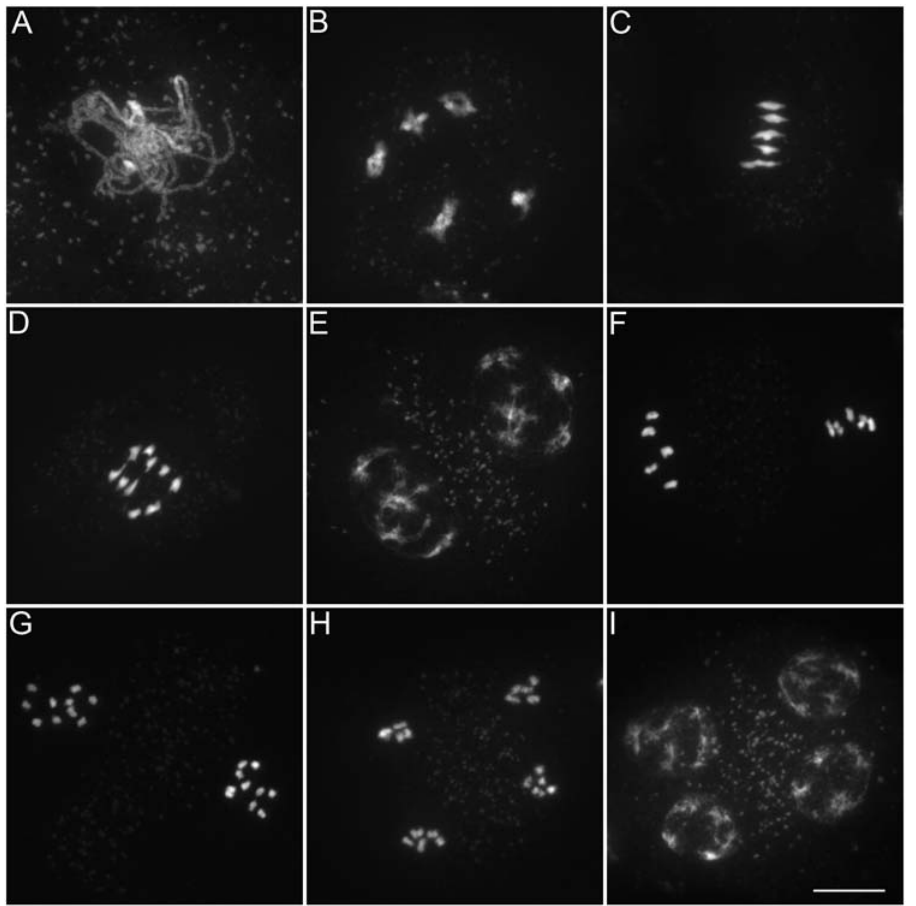
Figure 4. Meiosis in wild type. (A) Pachytene. Homologous chromosomes are fully synapsed. (B) Diakinesis. Five pairs of homologous chromosomes (bivalent), linked by chiasmata, are observed. (C) Metaphase I. The five bivalent are aligned on the metaphase plate. (D) Anaphase I. The homologous chromosomes are separated. (E) Telophase I. (F) Metaphase II. The pairs of sister chromatids align on the metaphase plates. (G) Anaphase II. The sister chromatids are separated. (H and I) Telophase II. Four haploid spores are formed (tetrad). Scale bar=10 m